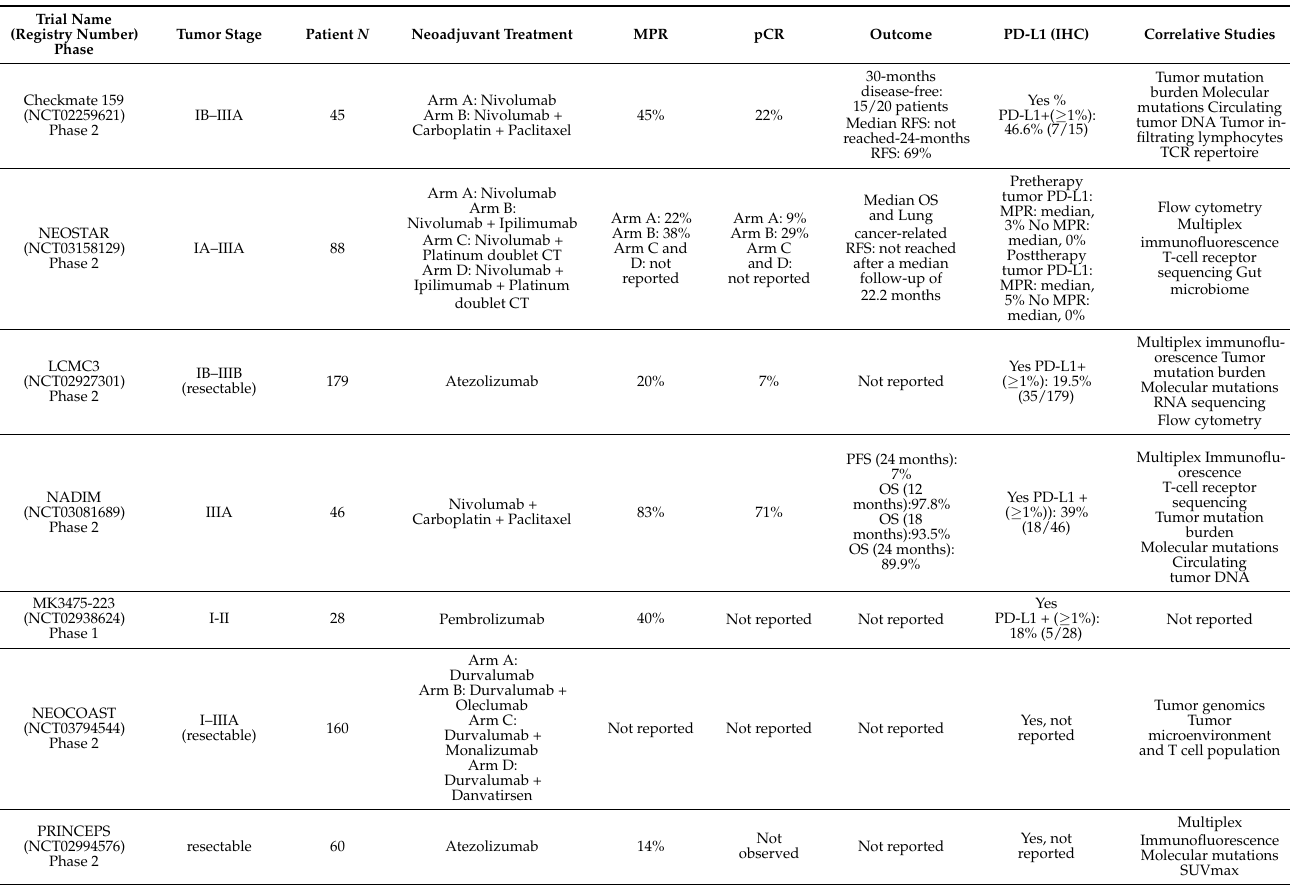
Table 1. Representative clinical trials for neoadjuvant immunotherapy alone or in combination with chemotherapy in resectable non-small-cell lung